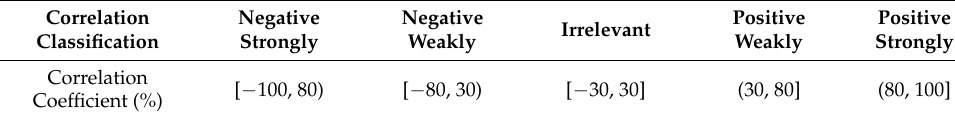
Table 15. Correlation classification.